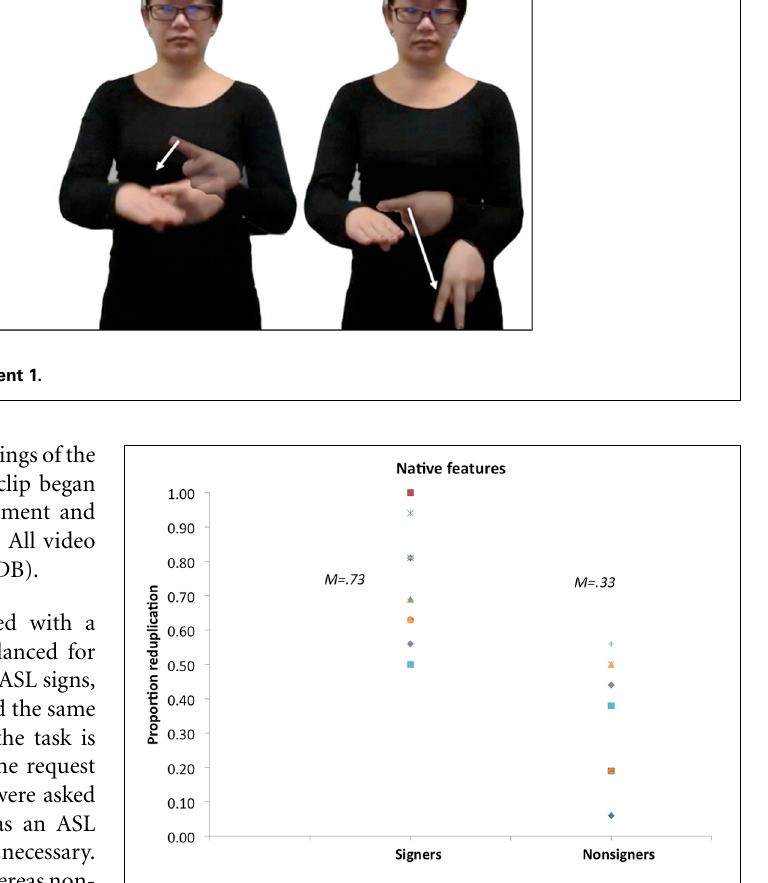
FIGURE 2 | Rating preference for reduplicated signs with native ASL features in Experiment